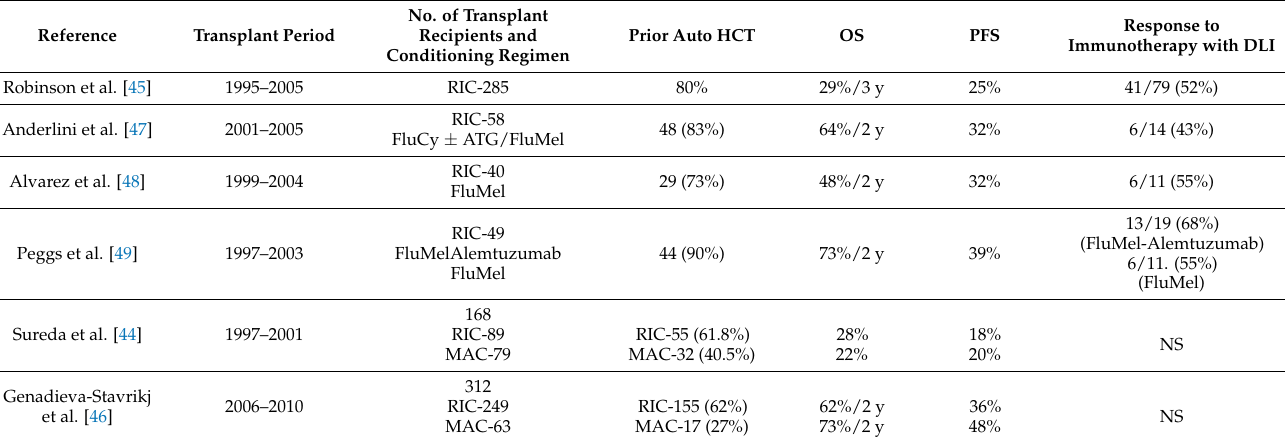
Table 4. Allogeneic SCT transplant for relapsed/refractory Hodgkin